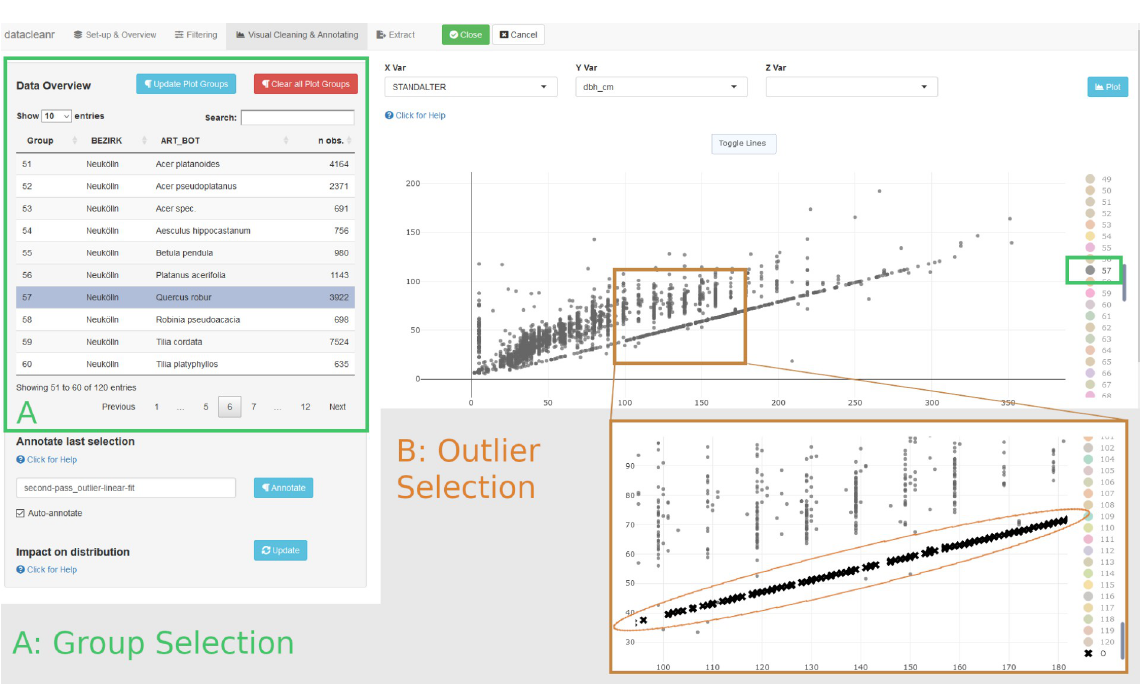
Fig 8. Identification of problematic data structures. Closer inspection of the tree dataset using the grouping structure (A) to highlight/hide specific groups. The obvious, near-perfect linear relationship between tree age and diameter at breast height requires further inspection. Concerning data points are easily selected leveraging the interactivity of the visualization by clicking or with a lasso tool (B, see inset).